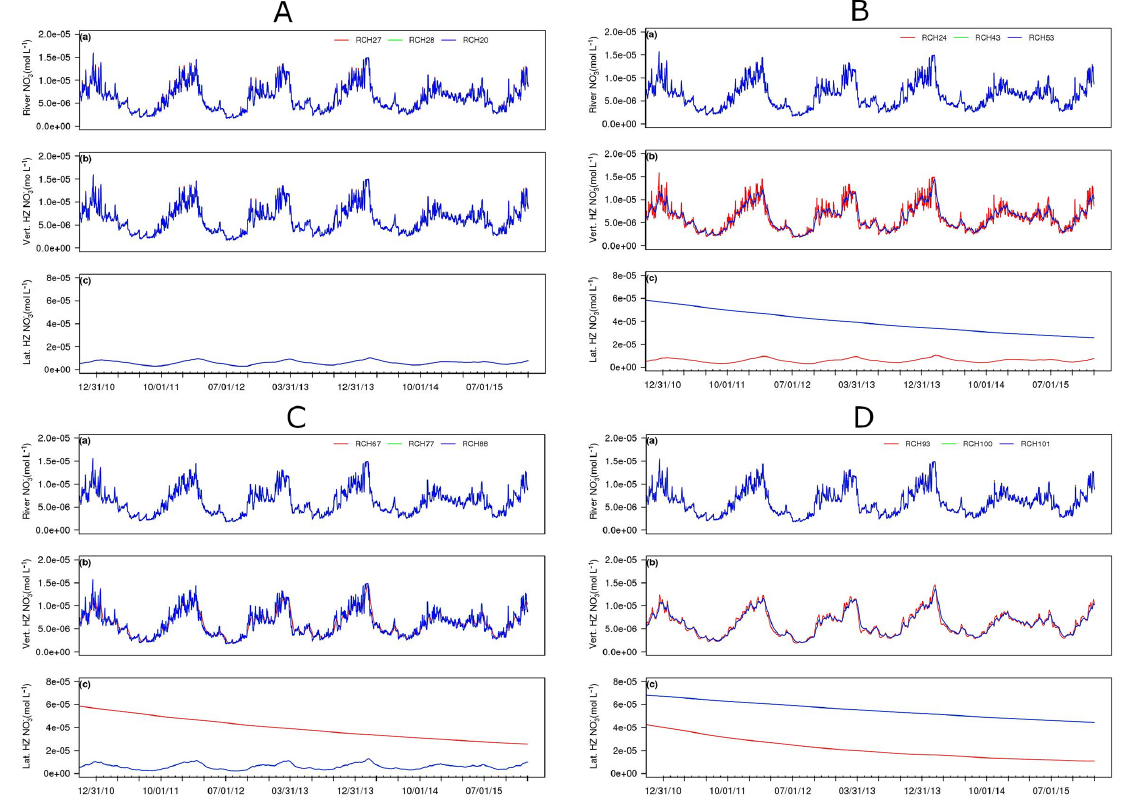
Figure 5. Comparison of nitrate in the river (a) , vertical HZ (b) , and lateral HZ (c) between reaches at the upstream (A) , in the middle of the stream (B, C) , and at the downstream (D) using